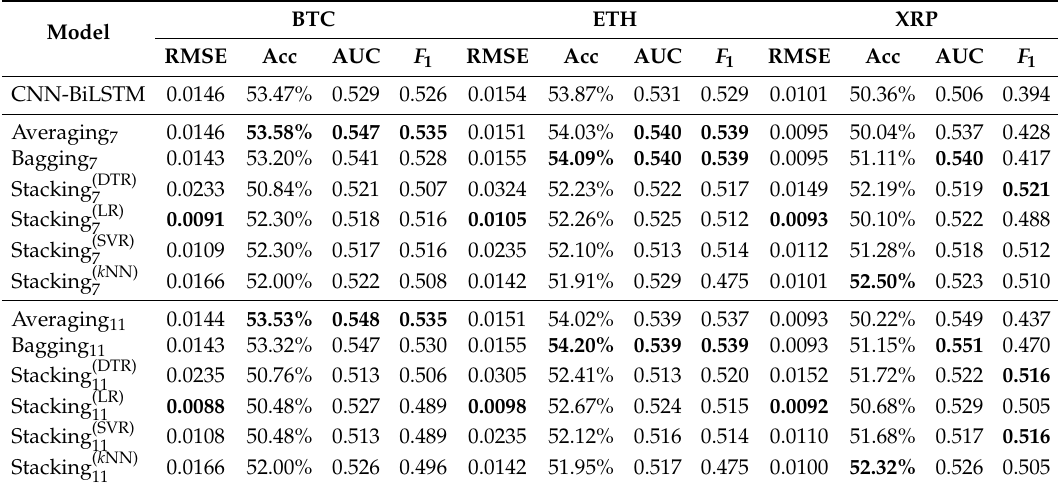
Table 6. Performance of ensemble models using convolutional neural network with CNN-BiLSTM as base learner for m =